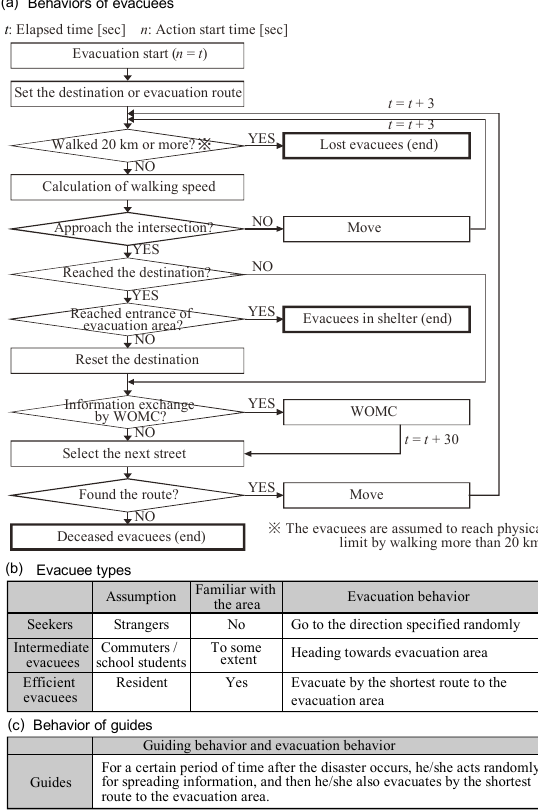
Figure 4. Evacuee types and behaviors of evacuees and